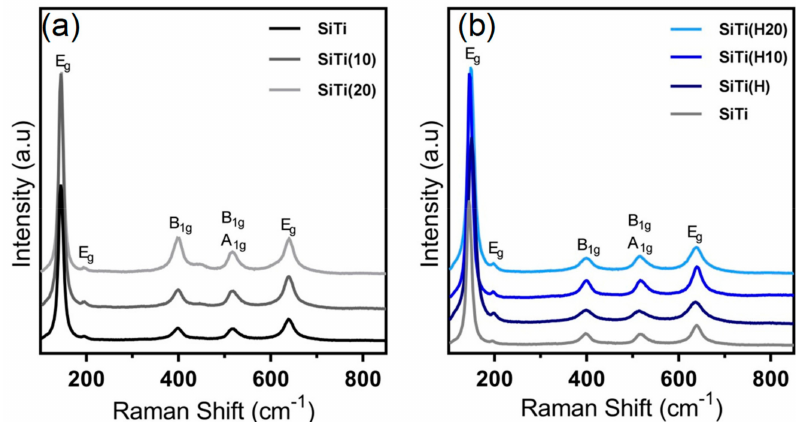
Figure 4. Raman spectra for FSP-synthesized SiTi, after the plasma treatment (with treatment time, in mins, in brackets) of ( a ) neat SiTi and ( b ) hydrogenated